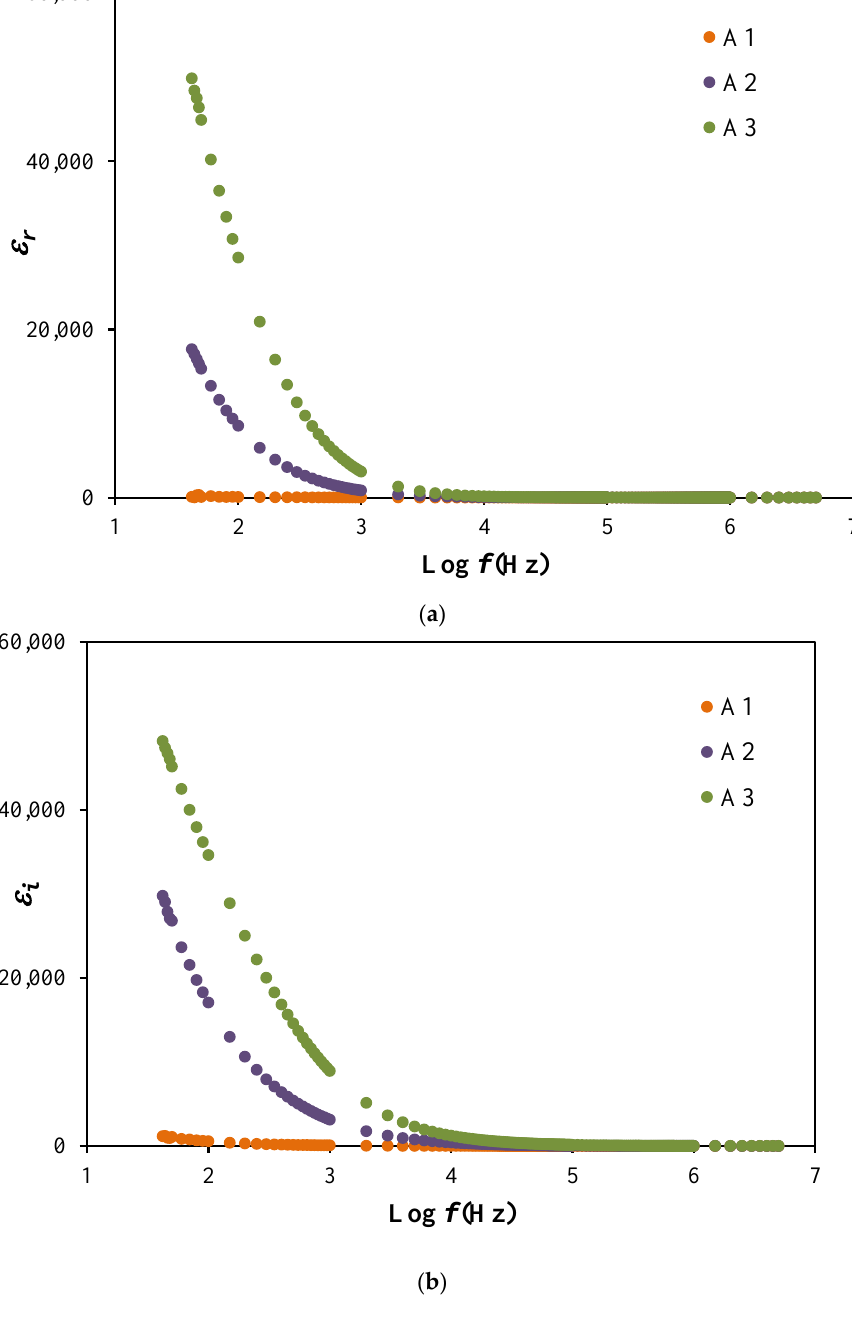
ε r and ( b ) i for the electrolyte